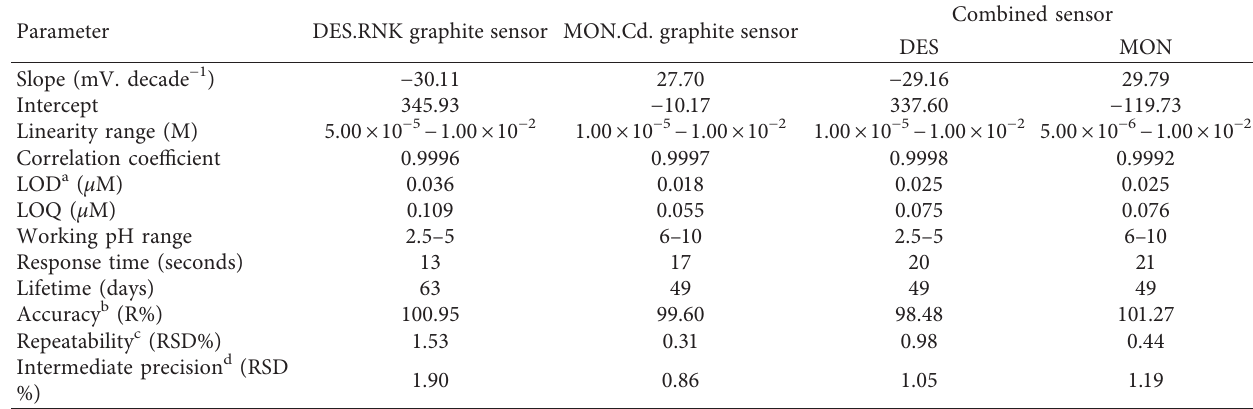
Table 1: The performance characteristics of the proposed described sensors.